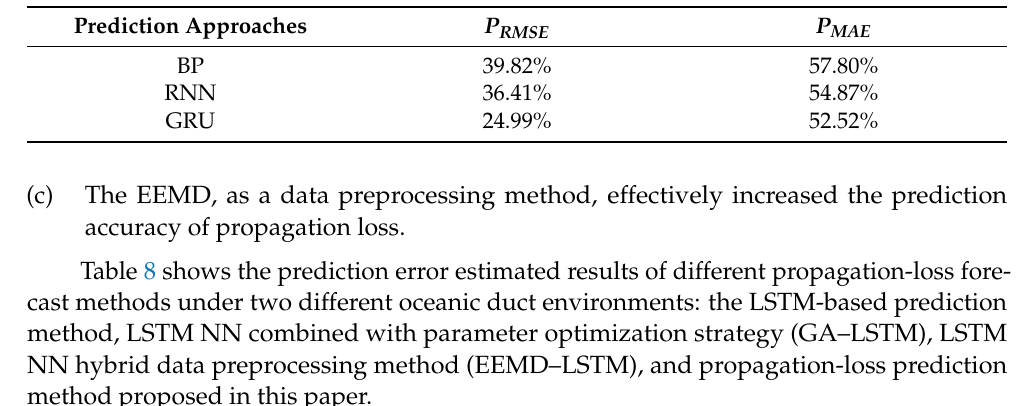
Table 7. Percentage improvements of the LSTM method in comparison with the other single NN approaches on propagation loss sequence 2 (surface duct).